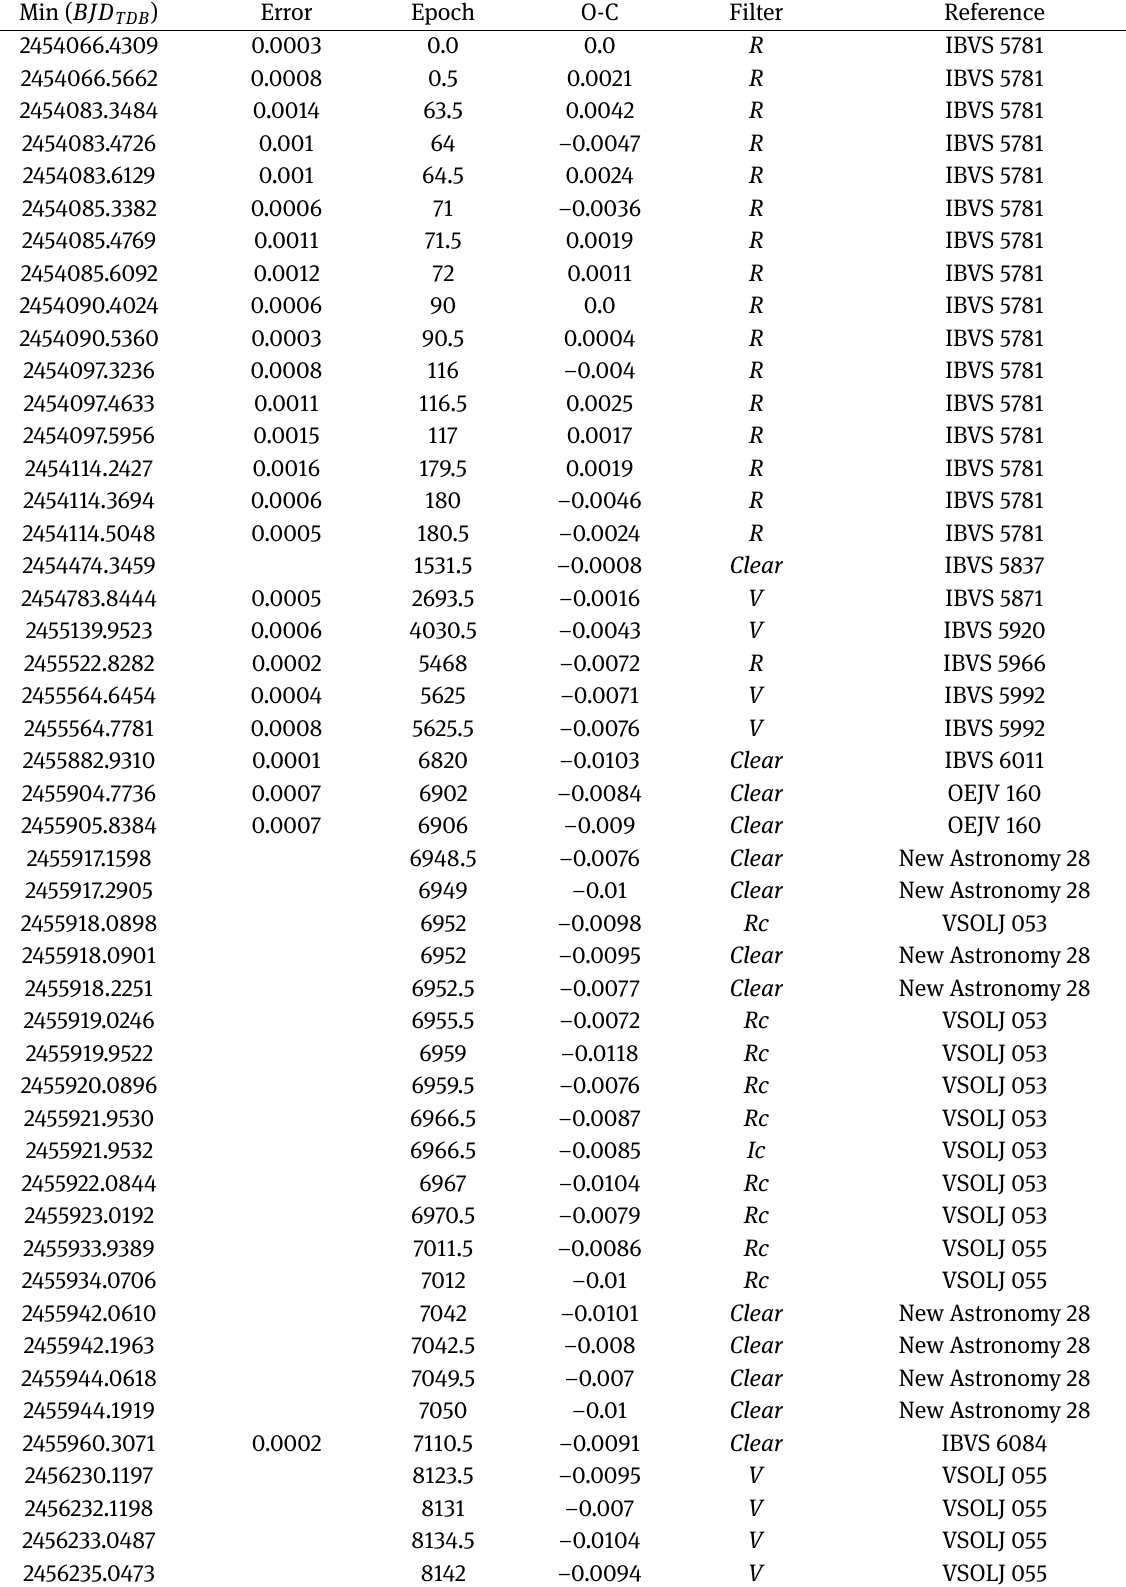
Table 3. Times of minima of V1848 Ori obtained by